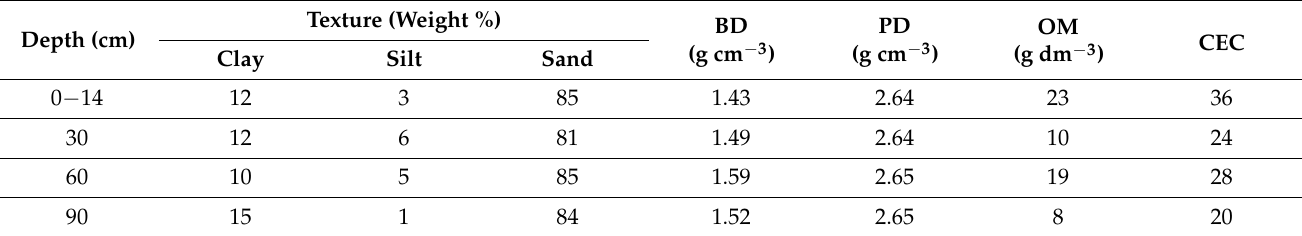
Table 1. Soil properties at 14, 30, 60, and 90 cm depth in the study area.